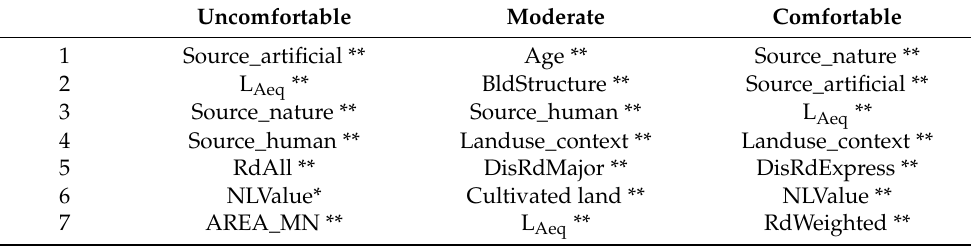
Table 2. A subset of the explanatory variables for the three levels of comfort score ranked by relative importance. The most important variable is in the first line and subordinate ones are subsequently following in the decreasing